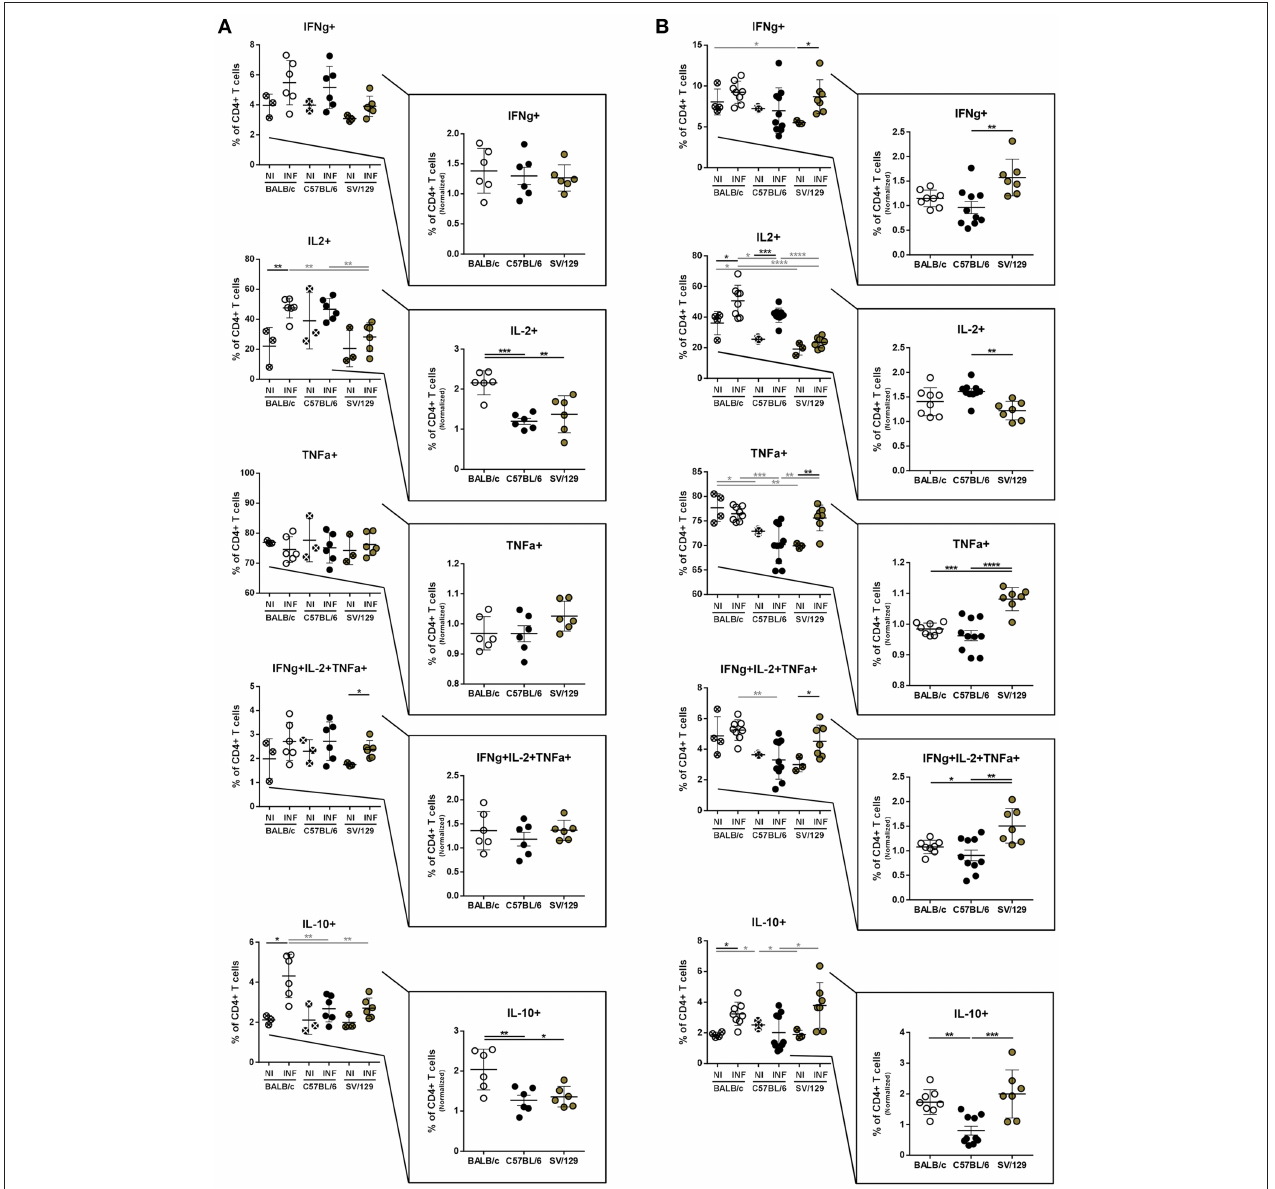
FIGURE 4 | Basal intracellular cytokine production by CD4 + T cells of the different mouse strains and it’s alteration 2- and 8-weeks post L. infantum infection. BALB/c (white circles), C57BL/6 (black circles), and SV/129 (brown circles) mice were infected intraperitoneally with 1 × 10 8 L. infantum promastigotes and euthanized 2 or 8 weeks after. Splenocytes were cultured with PMA + Ionomycin + Brefeldin A for 4h. CD4 + T cell frequencies producing IFN- γ , IL-2, TNF- α , and IL-10 were resolved by flow cytometry and are denoted for 2 (A) and 8 (B) weeks-infected animals and their respective controls. Results, obtained in at least two independent experiments, are represented both in total percentages (infected and control animals) and normalized (infected in relation to control group average values) as a way to highlight the infection-induced alterations. Each dot represents an animal. Average and SD of the values within each group are shown. Statistical differences are properly identified. One Way ANOVA (with Tukey’s post-hoc analysis) was used for comparisons between the different murine strains (infected or non-infected; gray lines), as well as for comparison of normalized values (black lines); t -tests (black lines) were performed for comparison between infected animals and controls from